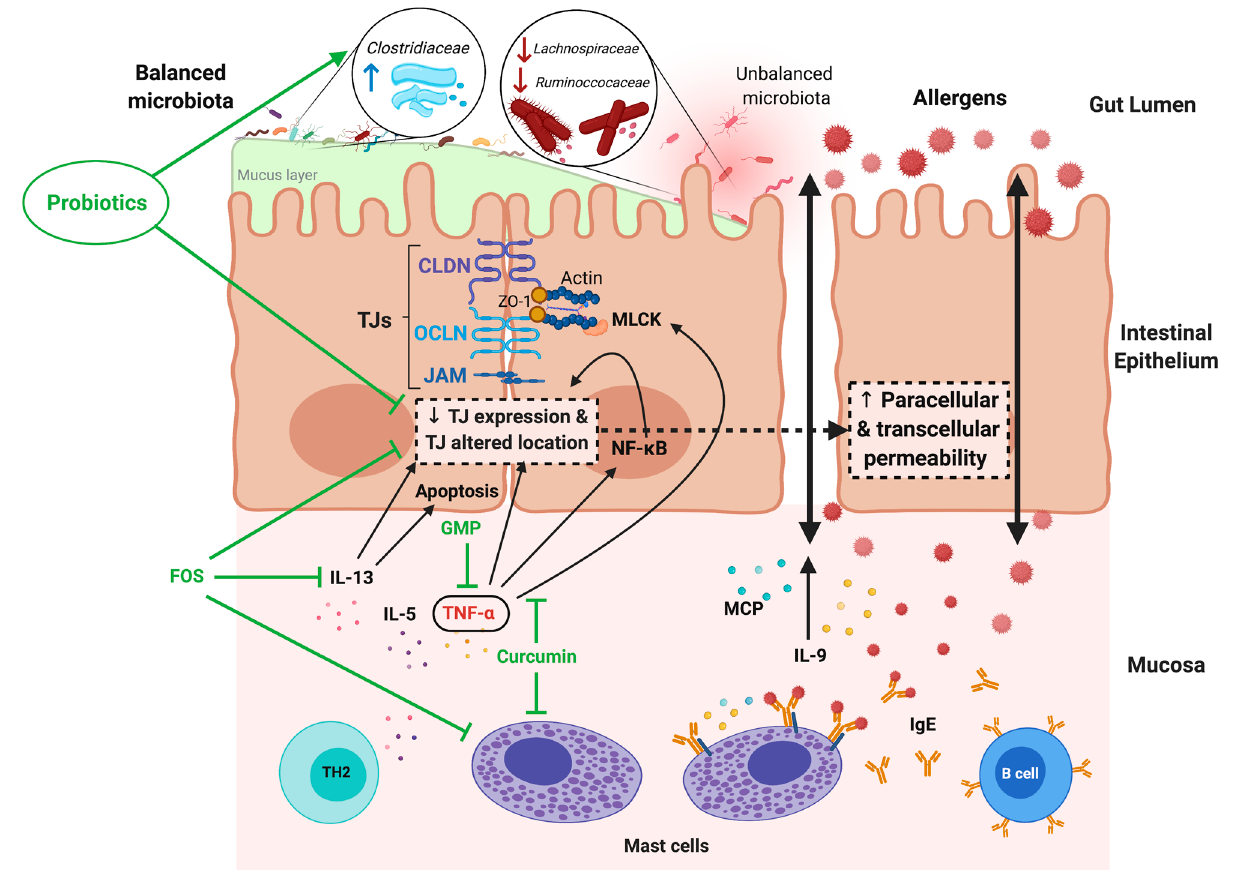
Figure 4. Increased intestinal permeability in food allergy (FA) and modulatory effects of probiotic, prebiotic, and food components. In the intestinal mucosa of allergic subjects, an inflammatory response develops that is dominated by Th2 cytokines, such as IL-5 and IL-13, which induce MC hyperplasia and allergen-specific IgE synthesis by B lymphocytes. In response to allergen recognition by IgE, which is bound to specific receptors on the MC surface, cells are activated and release TNF- α , proteases (MCP), and IL-9, as well as other inflammatory mediators. This allergic inflammatory environment induces a decrease in TJ expression and modifications that initiate an increase in the transcellular permeability of the mucosal epithelium. The augmented transcellular passage of allergens through enterocytes is also described during FA. Inflammatory mediators and mechanisms involved in the increased intestinal permeability during FA are indicated by black arrows. Treatment based on the oral intake of probiotic bacteria, prebiotics, and food components has shown beneficial effects in preventing or restoring the impaired barrier function in FA. The target molecules of these therapies are indicated by green lines. (This figure was created with Biorender.com, access date: 24 May 2021).